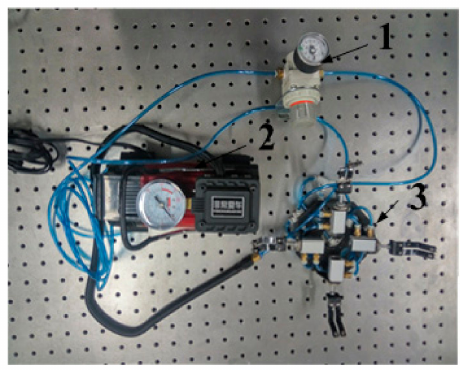
Figure 12. The grasping claws system prototype. 1—Pressure control valve, 2—vehicle mounted pump, 3—grasping module of the